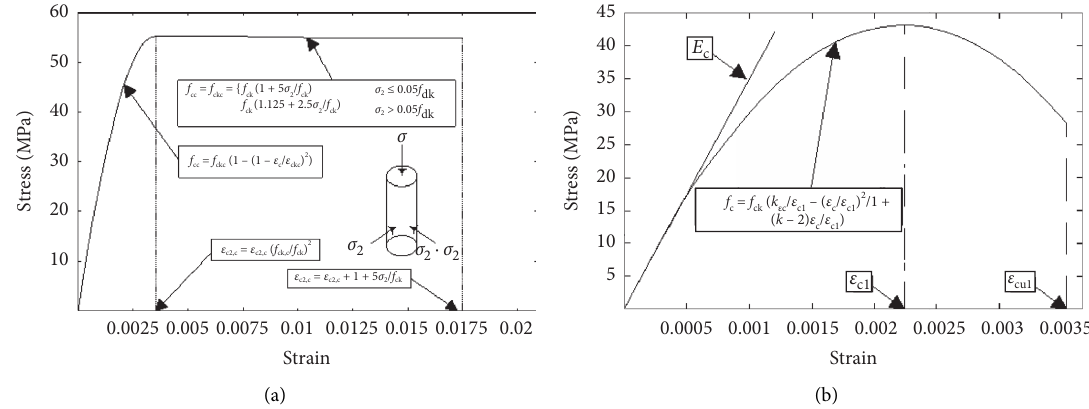
Figure 9: Material curve of concrete. (a) Confined concrete. (b) Unconfined concrete.